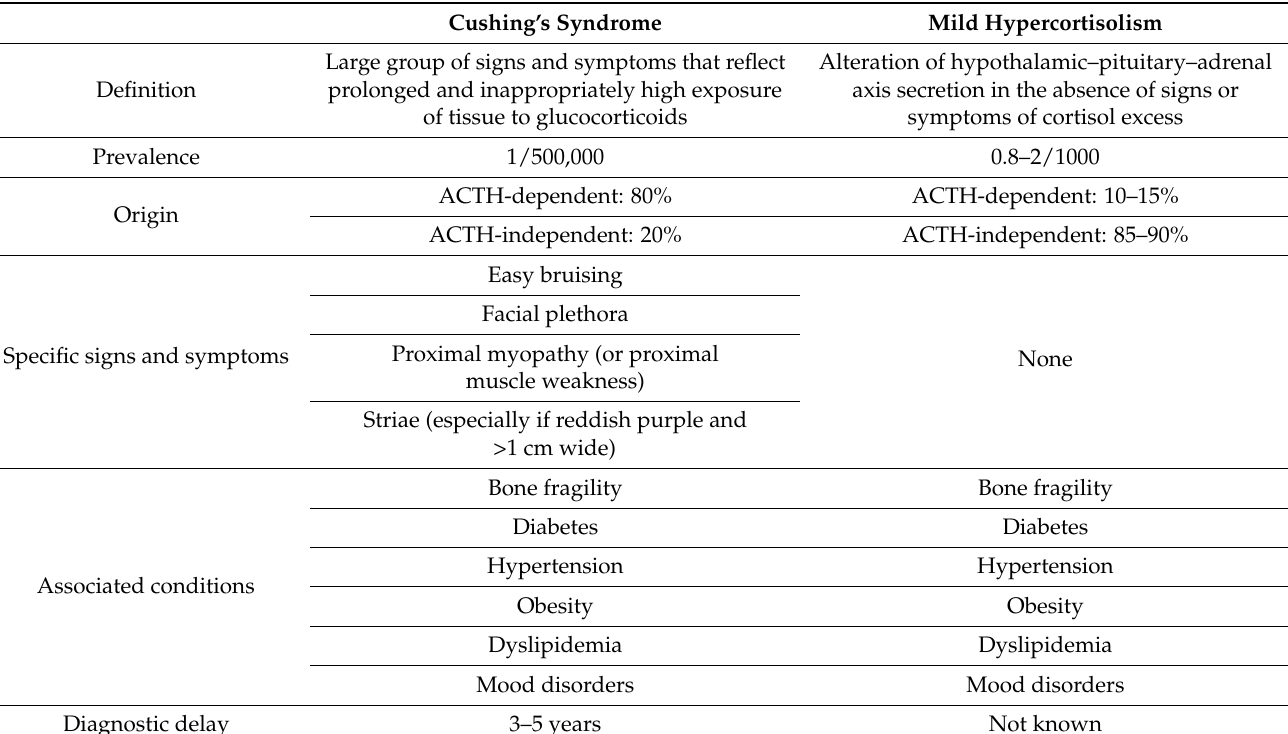
Table 1. Comparison of characteristics of Cushing’s syndrome and mild hypercortisolism.